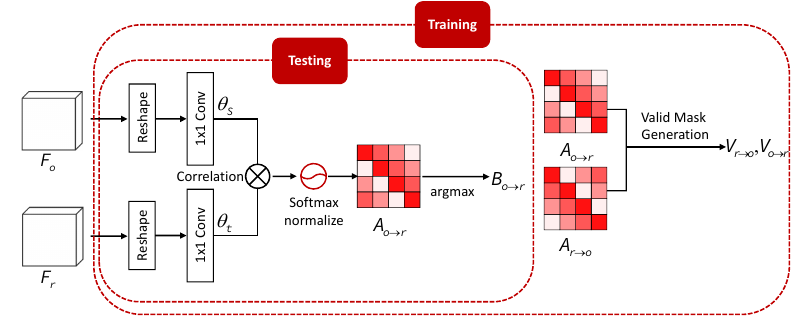
Figure 3. Illustration of the inter-attention module (IAM). Using discriminative features { F r , F o } , it outputs a hard inter-attention map B o → r for alignment in testing phase. Additionally, soft inter-attention maps { A o → r , A r → o } and valid masks { V o → r , V r → o } are used for photometric loss for training the